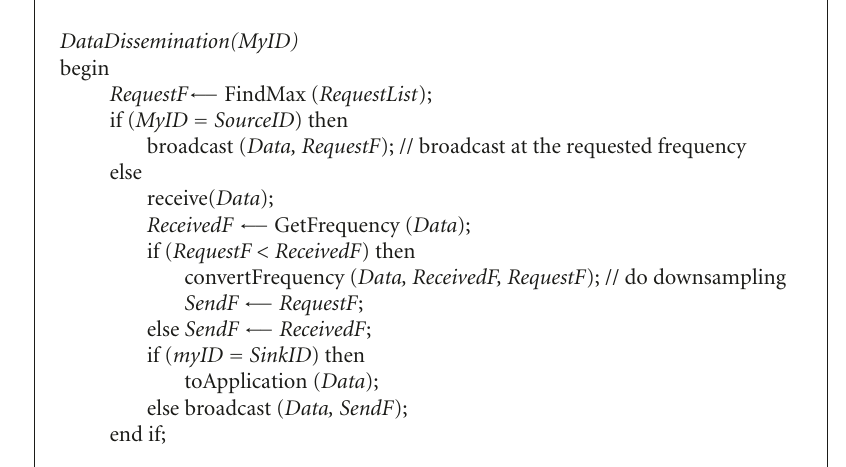
Algorithm 1: Data consolidation and dissemination.